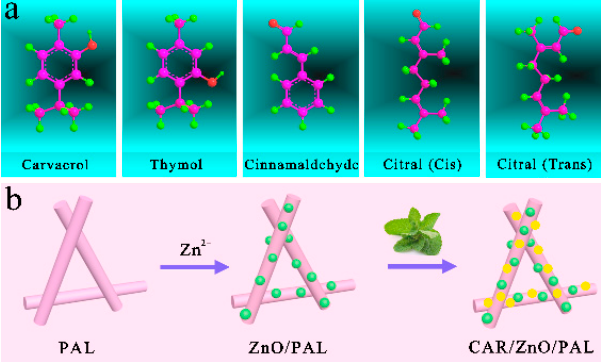
Figure 1. ( a ) Chemical structures of PEOs, ( b ) schematic illustration for the preparation of CAR/ZnO/PAL nanocomposites.